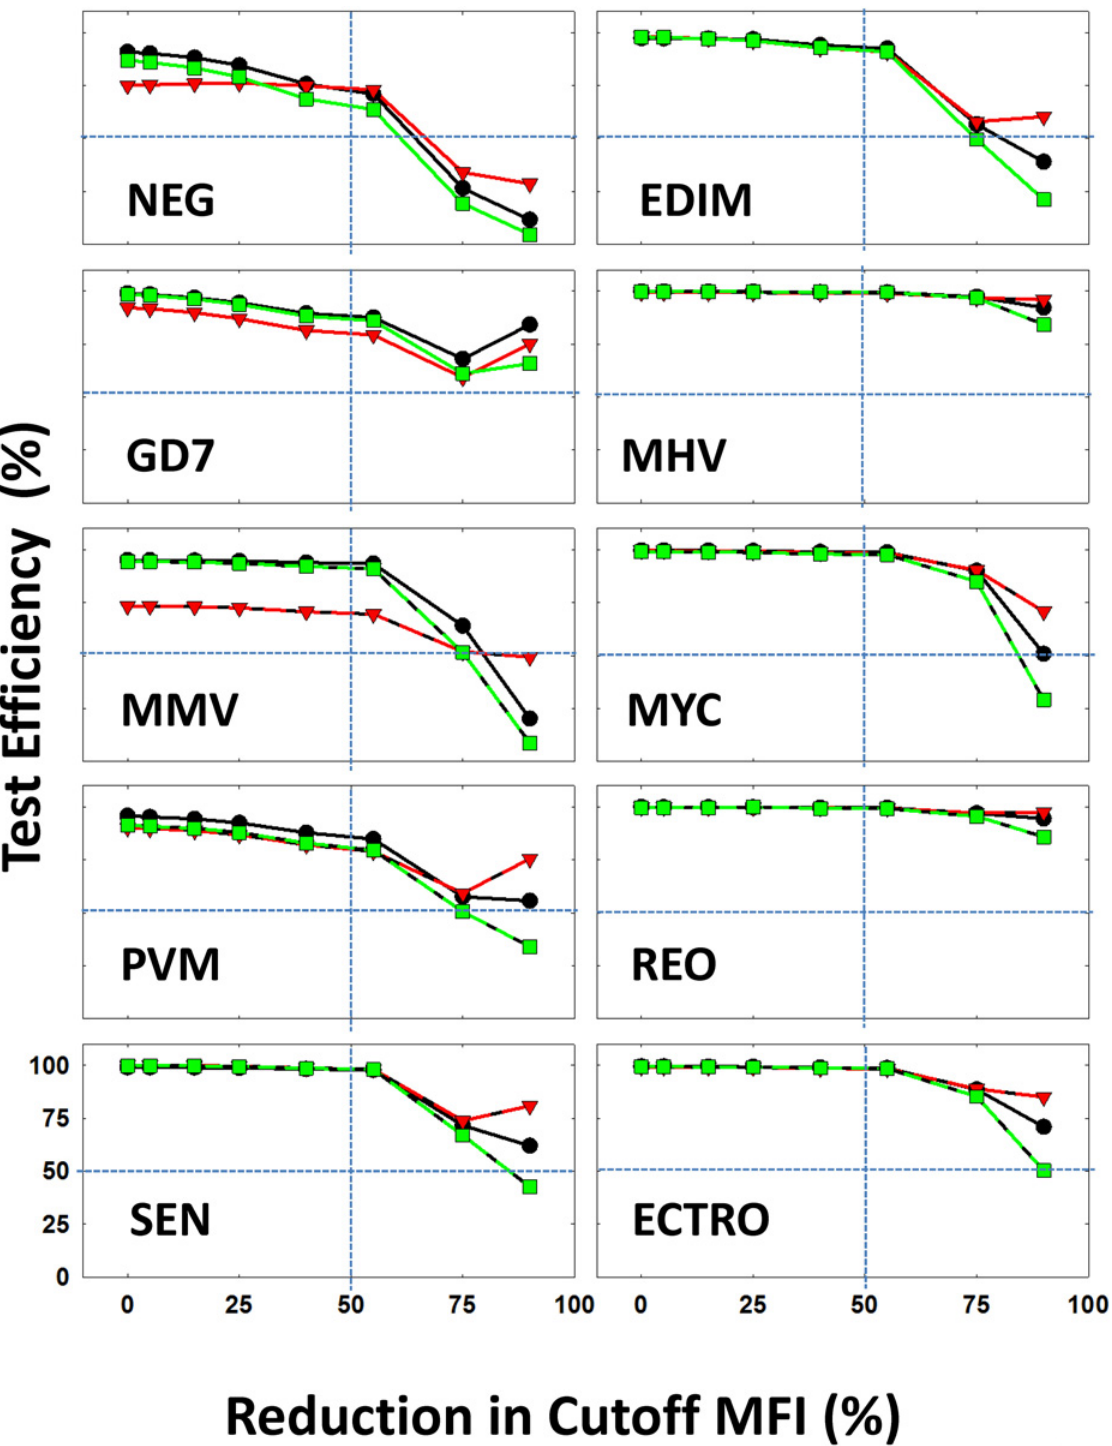
Figure 4. Assay tolerance performance in terms of test efficiency: The variation in the test efficiency (%) is plotted as a function of reduction in the experimental cutoff that is used to define the mice that are positive for each virus (marked) in each panel. The variation is calculated for three of the top performing algorithms: Meta Class Classifier (black symbols/lines), J48 (red symbols/lines) and Simple Logic (green symbols/lines). The experimental cutoff value is plotted at 0%. The 50% values along the X- and Y-axes are marked by vertical dotted lines. The abbreviations of the viruses are as follows: Epizootic diarrhea virus of infant mice (EDIM), Theiler ’ s mouse encephalomyelitis virus/GDVII strain (GD7), Mouse hepatitis virus (MHV), mouse minute virus